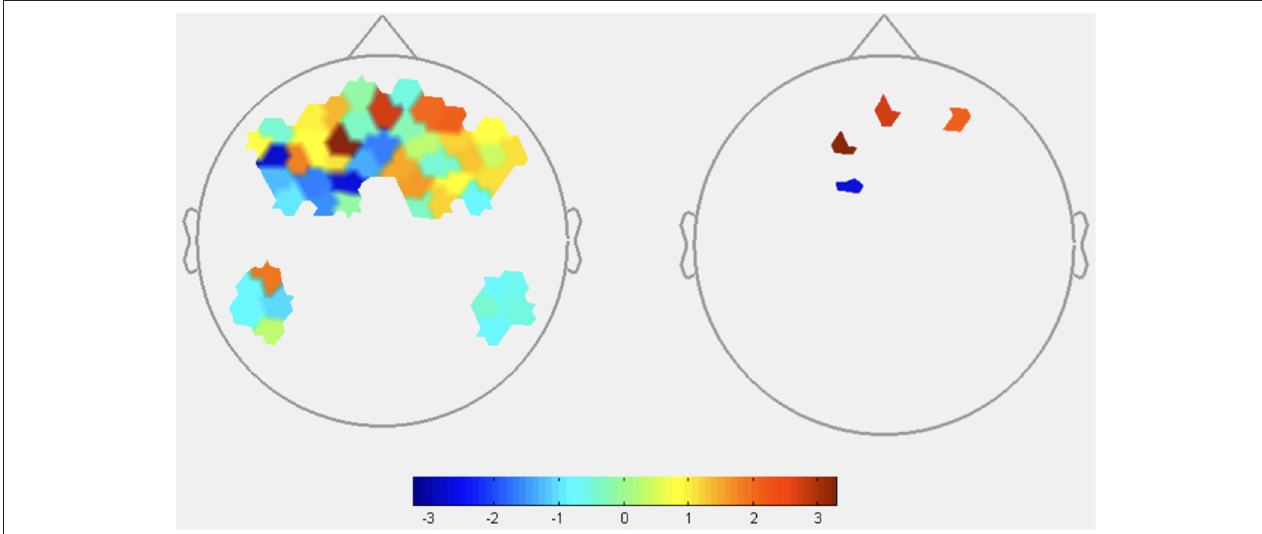
FIGURE 4 | HbO contrasts between low transparency and high transparency conditions: (T Low R Low + T low R High )–(T High R Low +T High R High ). Left image displays all t-values, right image displays t-values that are statistically significant ( p < 0.05). Red coloration indicates more activation (higher HbO) during low transparency conditions compared to high transparency. Conversely, blue indicates more activation (lower HbO) during high transparency conditions.